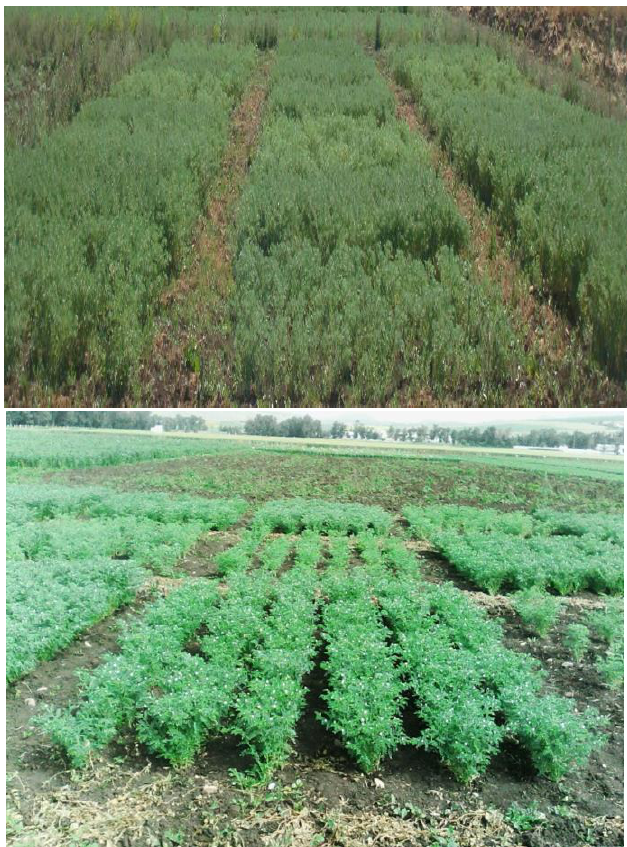
Figure 2: Experimental design respectively at Oued Mliz and